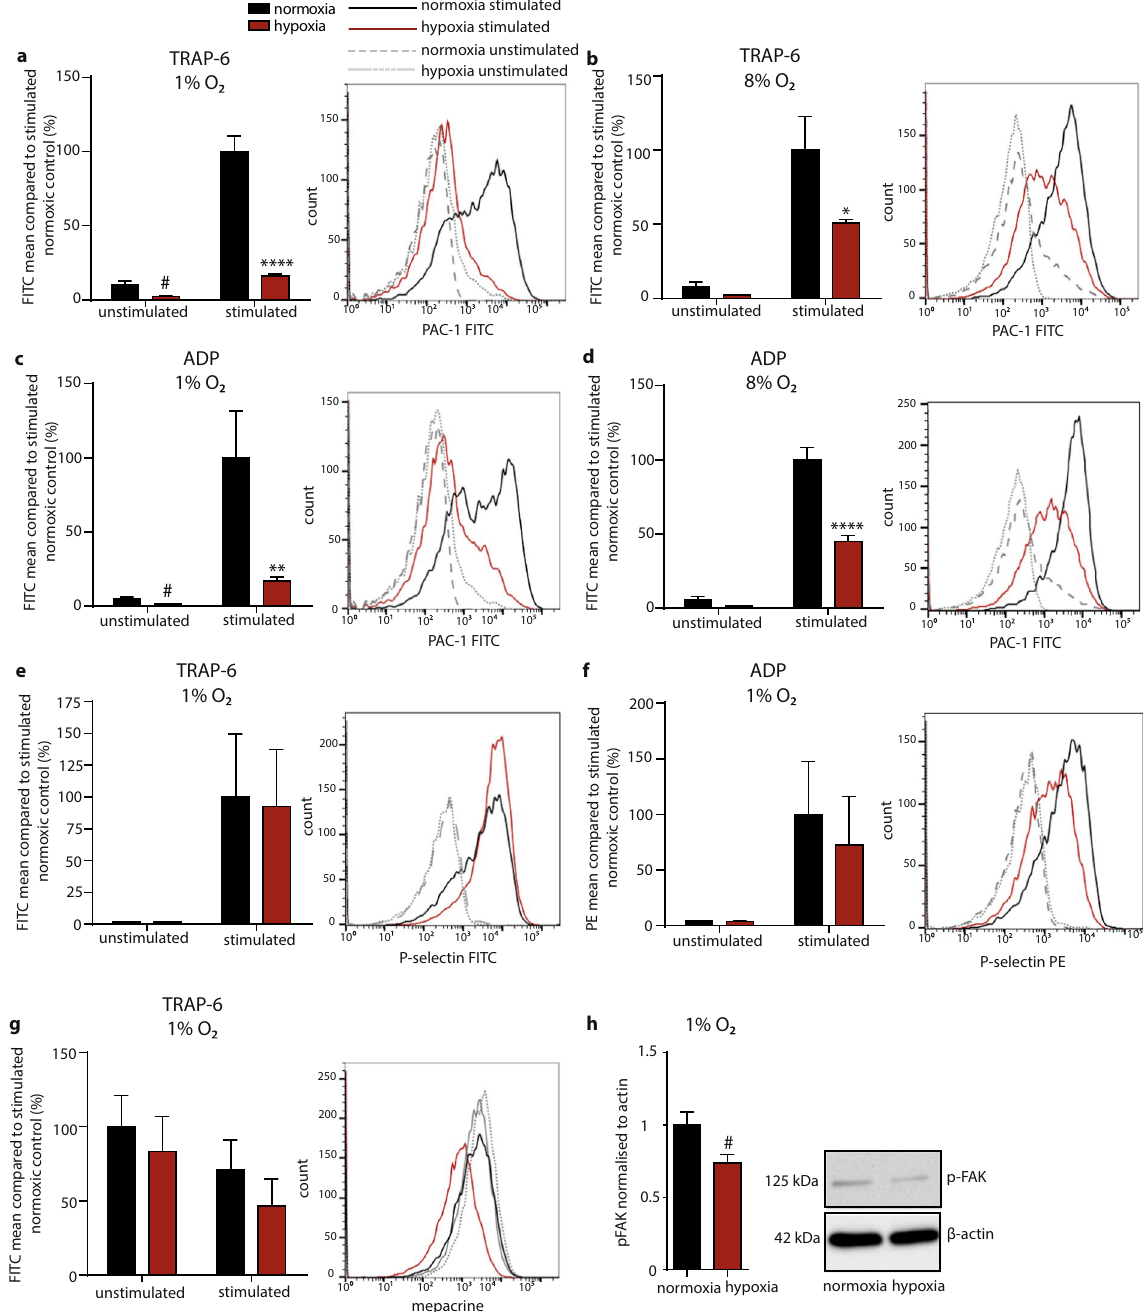
Figure 2. Activation defects of α IIb β 3 after platelet incubation in hypoxia (1% or 8% oxygen). Mean fluorescence intensity of FITC-conjugated PAC-1 antibody as percentage compared to stimulated normoxia control (100%) of unstimulated and stimulated platelets with 5 µ M TRAP-6 in ( a ) 1% O 2 (n = 6), ( b ) 8% O 2 (n = 3) and 5 µ M ADP in ( c ) 1% O 2 (n = 5), ( d ) 8% O 2 (n = 3) after 30 min incubation in normoxia or hypoxia. Mean fluorescence intensity of the P-selectin antibody binding to unstimulated and stimulated platelets with ( e ) 5 µ M TRAP-6 (n = 3) and ( f ) mean fluorescence intensity of the P-selectin antibody binding to unstimulated and stimulated platelets with 5 µ M ADP (n = 3, 2) after 30 min incubation in normoxia or hypoxia. ( g ) Mean fluorescence intensity of mepacrine-labelled unstimulated and stimulated platelets with 5 µ M TRAP-6 after 30 min incubation in normoxia or hypoxia. ( h ) Representative cropped blot of FAK phosphorylation normalized to β -actin of washed platelets stimulated with 5 µ M TRAP-6 (n = 12, p = 0.0437). Unstimulated platelets in normoxia are shown in black, in hypoxia in red, stimulated normoxic platelets are represented as black, hypoxic as red. All data were expressed as the means ± SEM. Statistical comparisons were performed using the two-way ANOVA, ** p < 0.01, **** p ≤ 0.0001 or the paired Student’s t -test, # p < 0.05 Data from ( h ) passed the Shapiro- Wilk normality